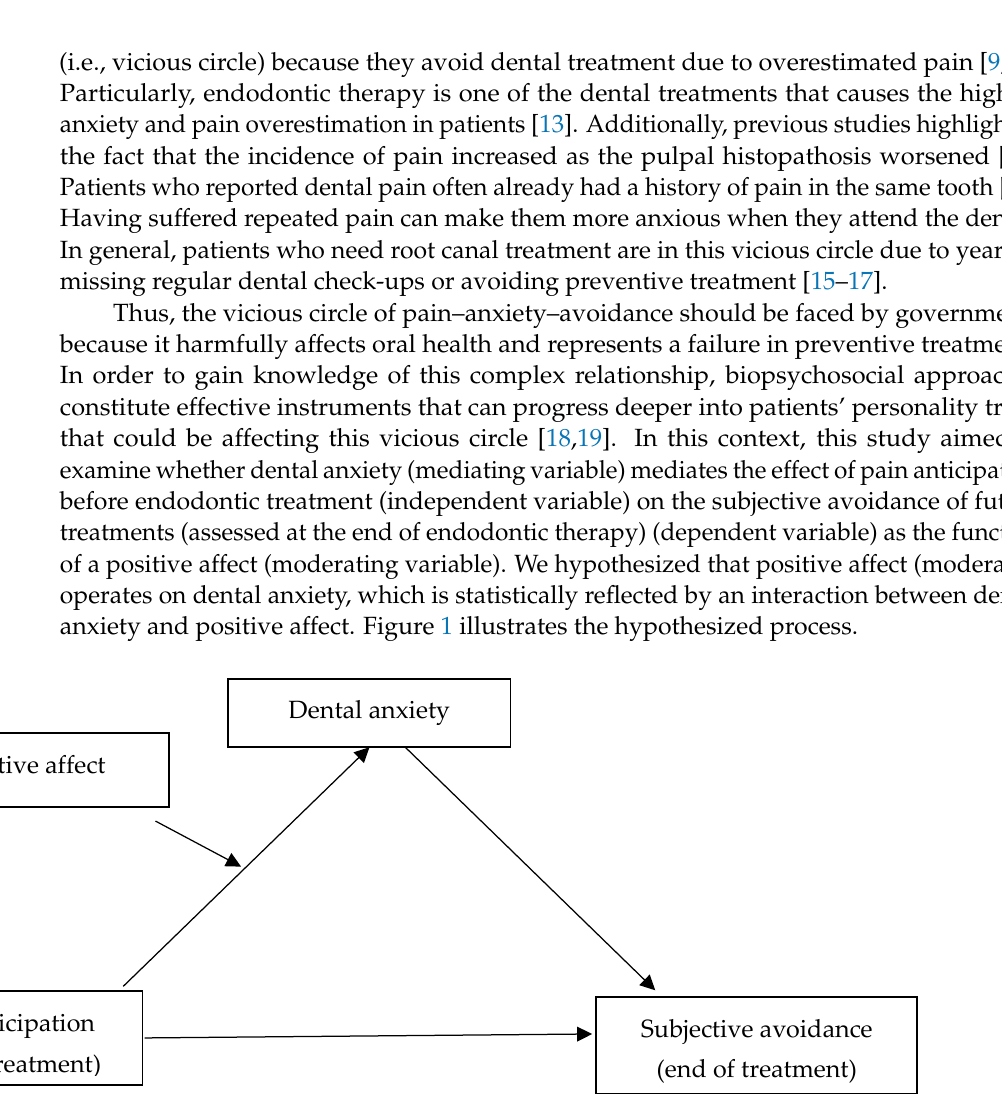
Figure 1. Proposed model of moderated mediation.